Question: Express in one sentence what the figure is showing.
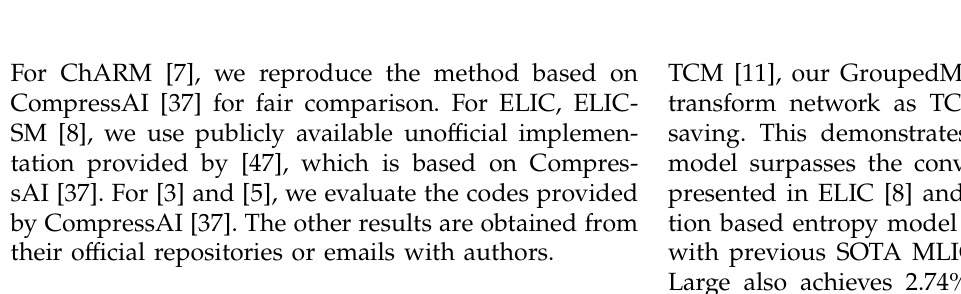
Answer: Performance evaluation on the Kodak dataset.